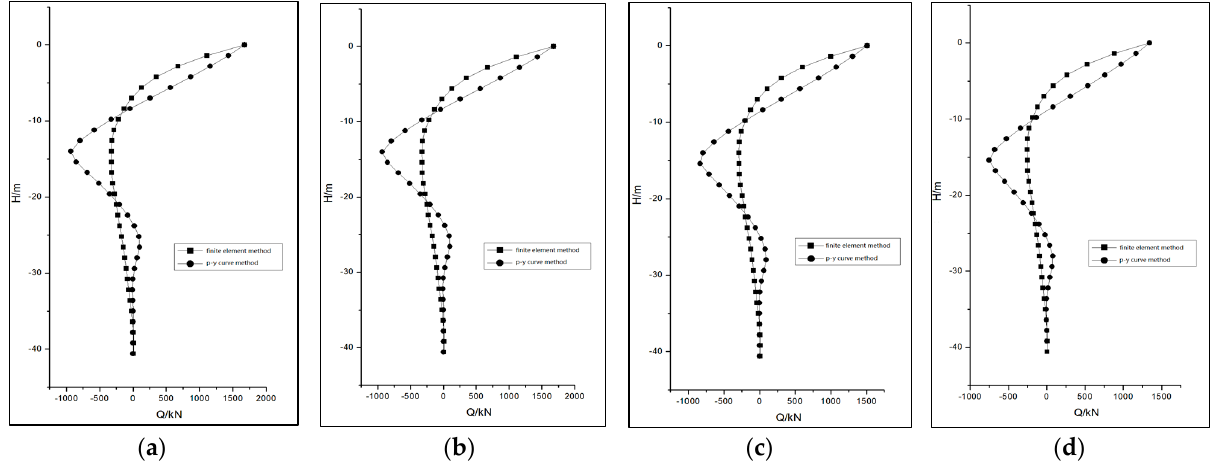
Figure 19. Pile shear force behavior: ( a ) inclined pile; ( b ) front pile; ( c ) middle pile; ( d ) back pile.